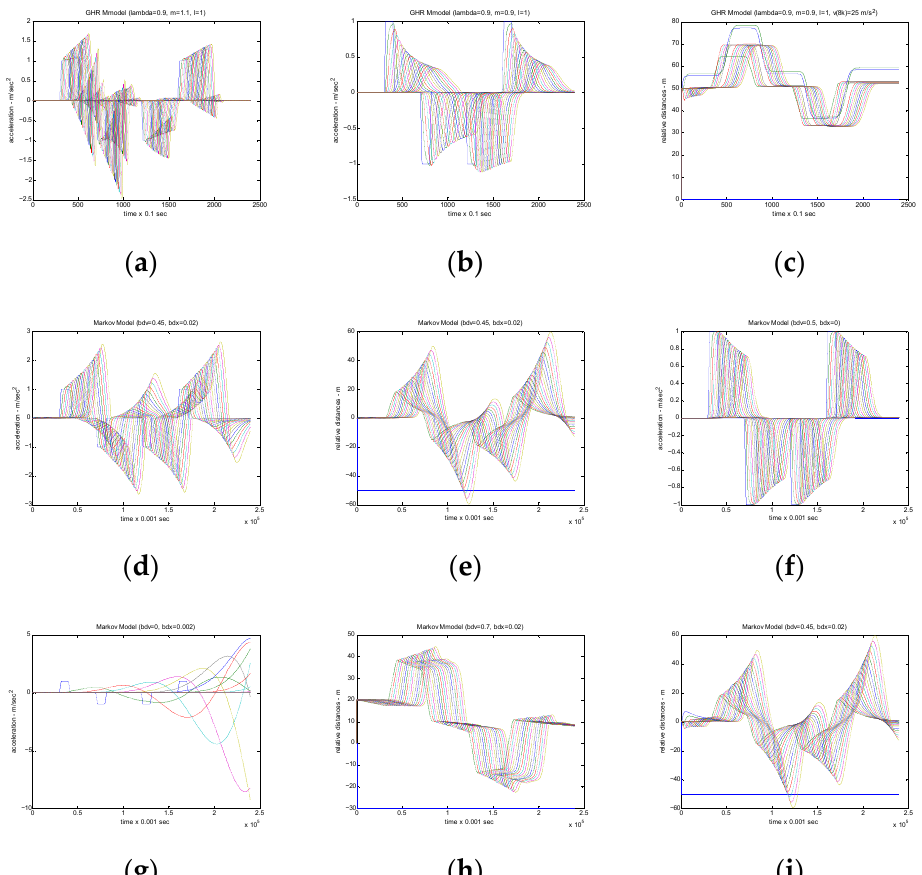
Figure 6. Effects of changes in model parameters on the results (the horizontal axis is time; the vertical axis is value). ( a ) GHR model with changed m (m = 1.1); ( b ) GHR model with changed m (m = 0.9); ( c ) GHR model m = 0.9 and v 8 = 25 m / s at the t = 0; ( d ) Markov model—b dc increased 10 times; ( e ) Markov model—b dx increased 10 times; ( f ) Markov Model—b dx = 0; ( g ) Markov model—b dv = 0; ( h ) Markov